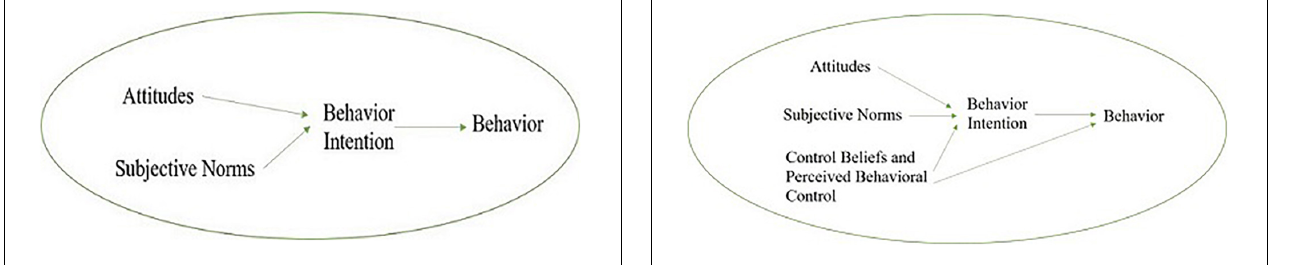
FIGURE 1 | Conceptual model of rational behavior theory. FIGURE 2 | Conceptual model of planned behavior